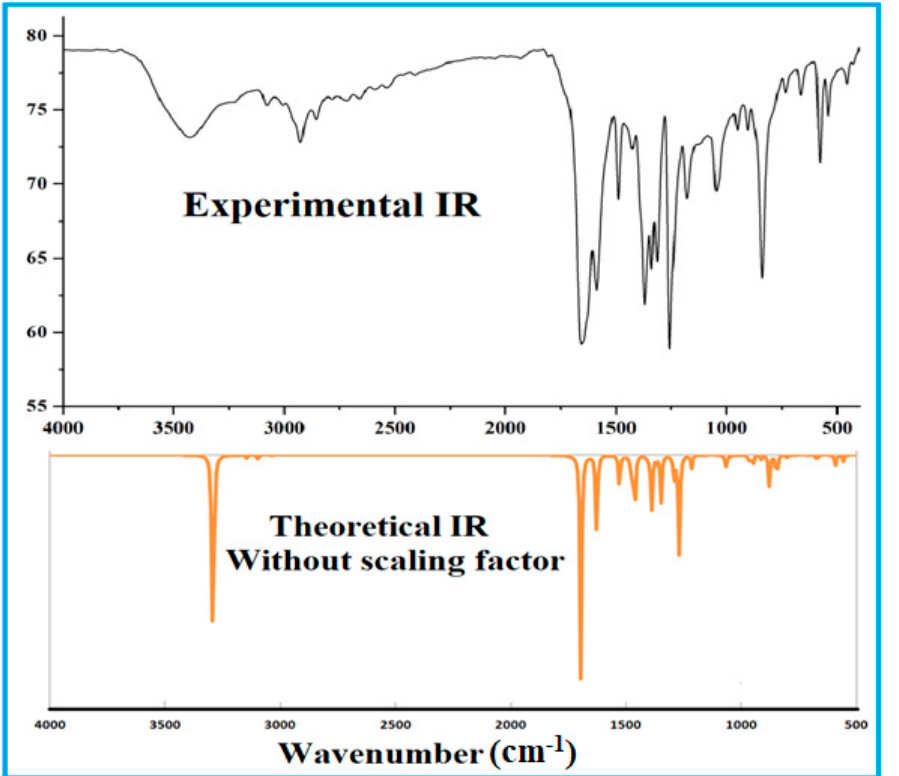
Figure 4. Theoretical and experimental IR spectra of compound 1 .